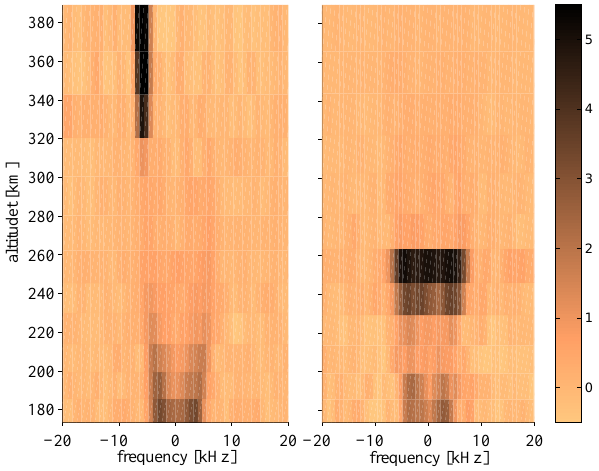
Fig. 1. Incoherent radar spectra taken with ESR. The left panel shows a typical NEIAL at altitudes above 300km on 9 April 2007 at 11:31:54UT. The right panel shows a different kind of spectral enhancement seen on 1 August 2007 at 00:43:00UT. Both spectra were integrated 6s. The colour bar shows range corrected power spectral density in arbitrary units.